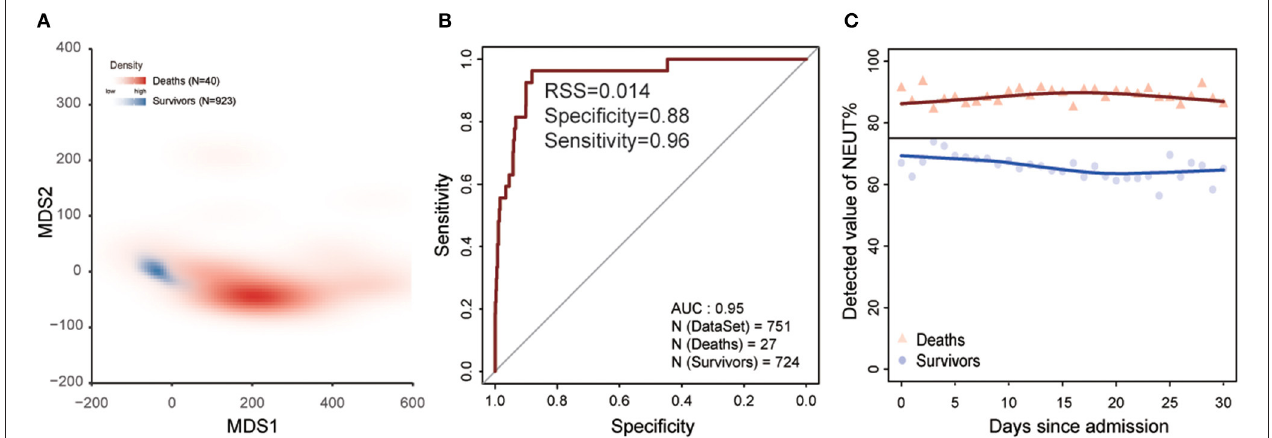
FIGURE 4 | Laboratory findings to predict the clinical outcome of COVID-19 within the 1st week after admission. (A) MDS plot for distinguishing deaths from survivors based on 13 laboratory findings in training dataset. Red represents deaths and blue represents survivors. (B) The ability of the model for distinguishing deaths from survivors based on 13 laboratory findings in the test dataset. The x-axis is specificity and the y-axis represents sensitivity. (C) The change in the percentage of neutrophils since admission. The black line is the maximum reference value. The blue dot represents survivors and red represents